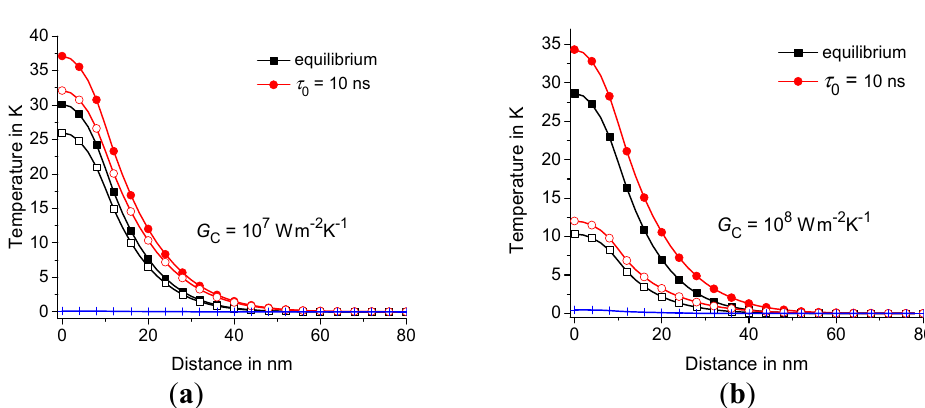
Figure 7. Temperature distribution along the z -axis at G C = 10 7 W / m 2 K ( a ) and 10 8 W / m 2 K ( b ). T ( t , R C /2, z ) and T ( t , R 1 , z ) are represented by the filled and open symbols, respectively, and T CNT ( t , z ) is represented by the crosses. The equilibrium and nonequilibrium solutions at τ 0 = 10 ns are represented by squares and circles, respectively; t = 1 ns and τ p = 2 ns. The geometric parameters are the same as in Figure 6.